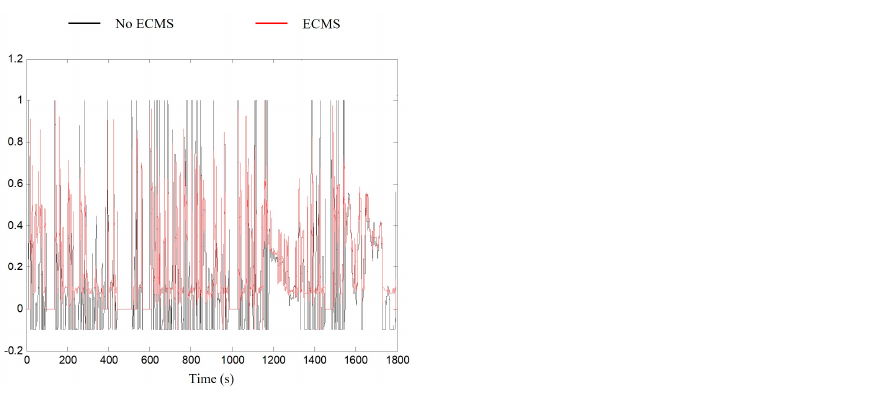
Figure 11. Engine load corresponding to different power systems under WLTP test conditions.